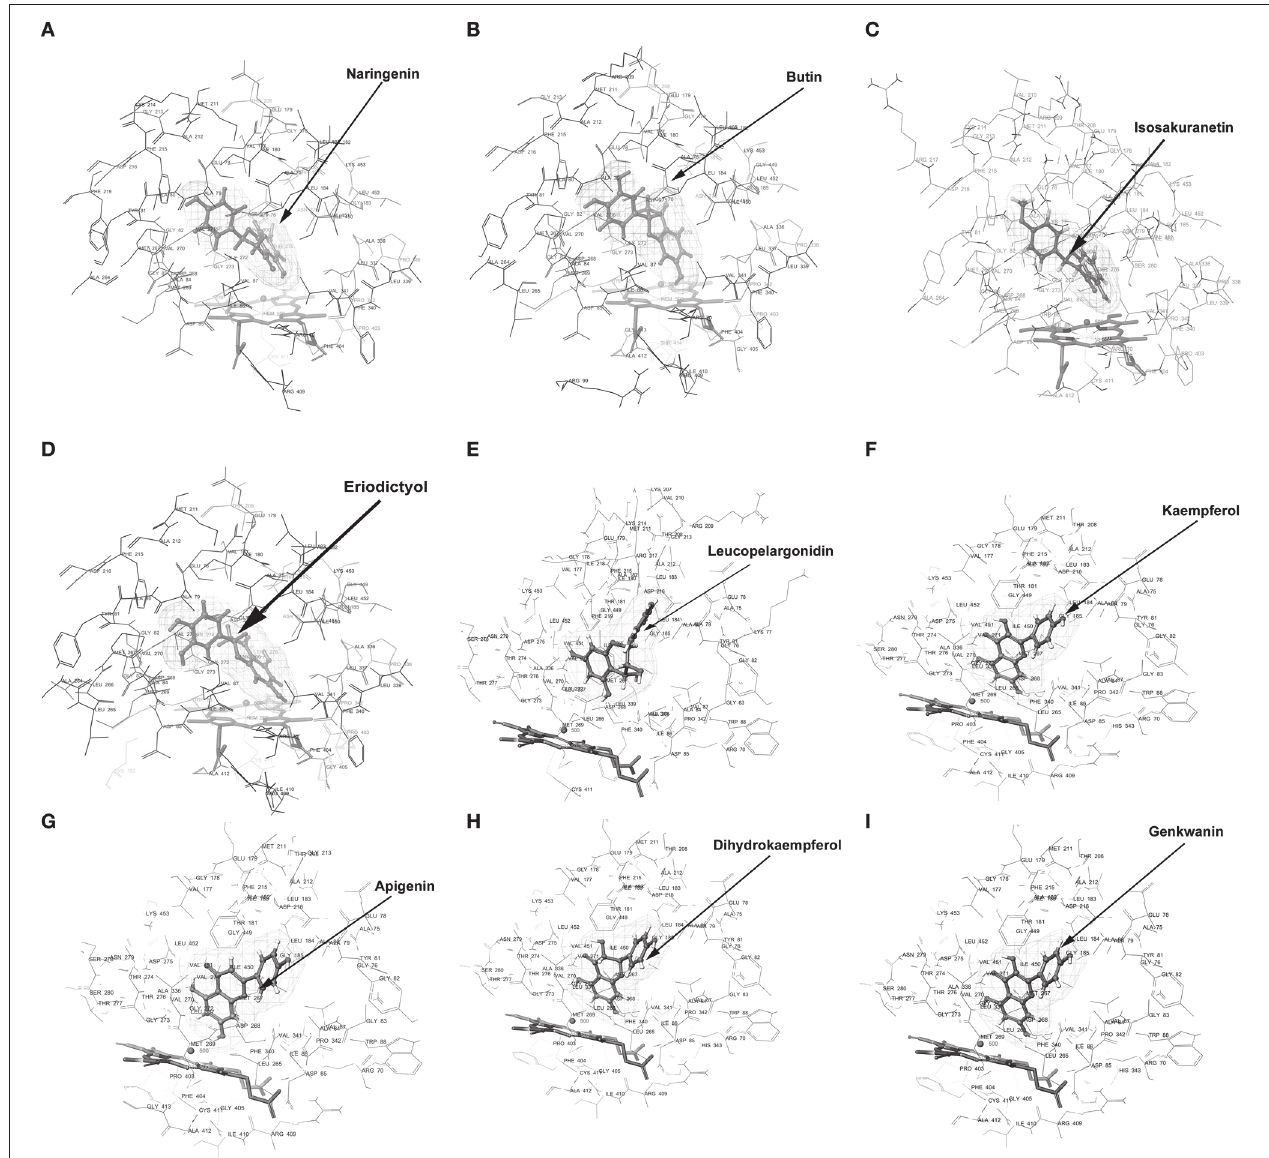
FIGURE 5 | Molecular docking of CfCYP706C. Diagram (A) Naringenin, (B) Butin, (C) Isosakuranetin, (D) Eriodictyol, (E) Leucopelargonidin, (F) Kaempferol, (G) Apigenin, (H) Dihydrokaempferol, (I) Genkwanin, docked in the proposed binding pocket (above heme plane) of CfCYP706C. Mesh represents the ligand surface.